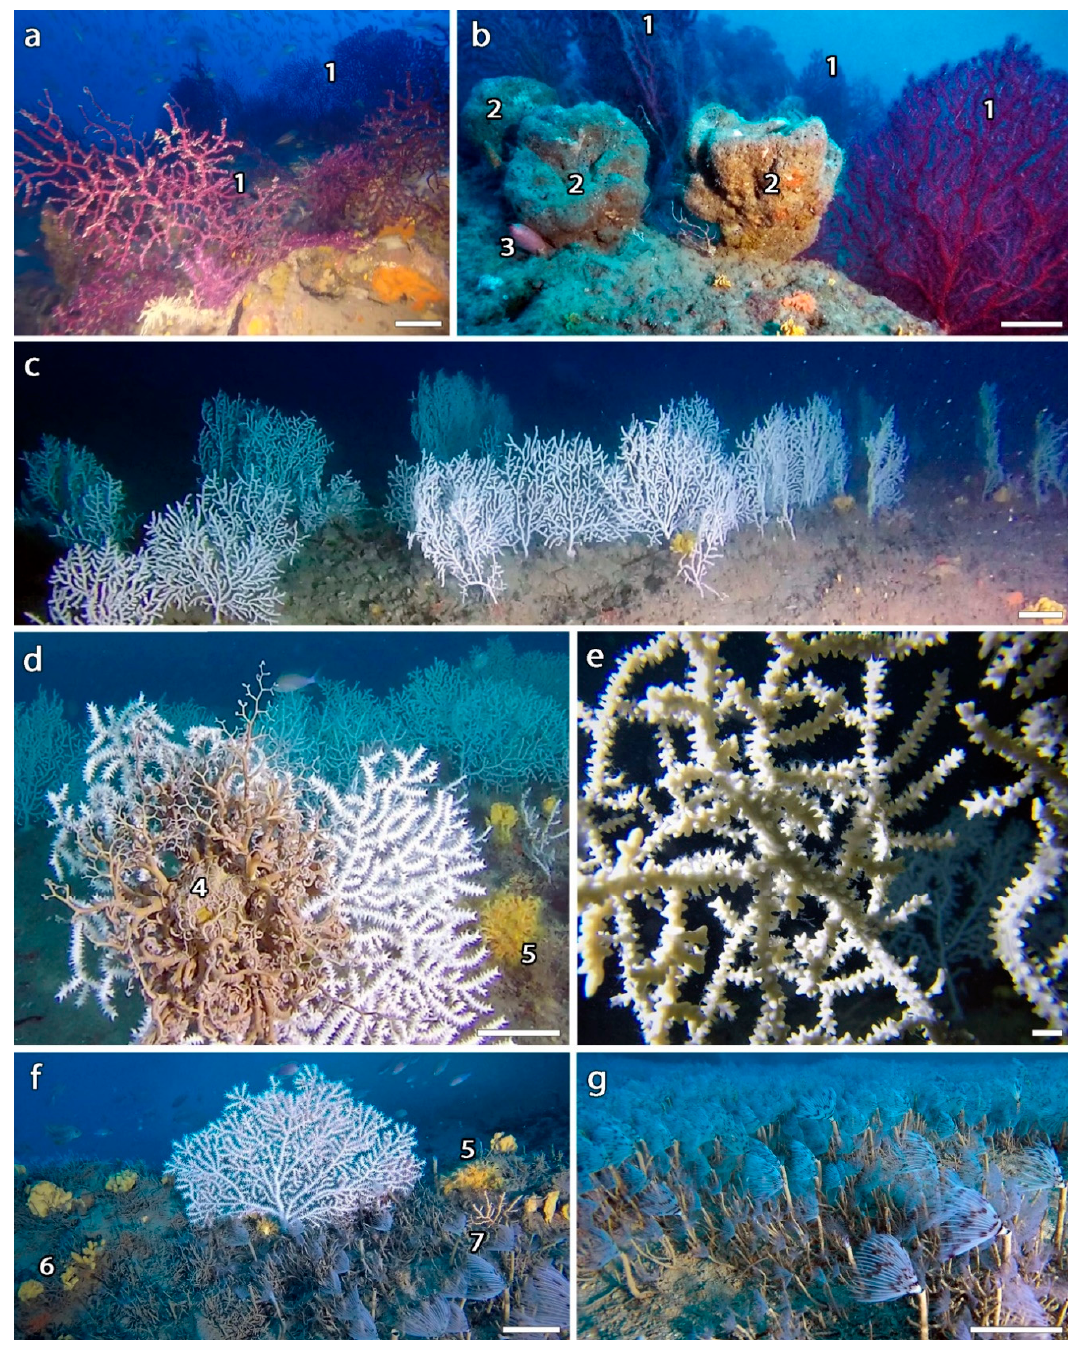
Figure 1. Benthic communities off Sanremo. ( a ) Forest of Paramuricea clavata (1), with ( b ) massive sponges (2) and the ascidian Halocynthia papillosa (3); ( c ) forest of Eunicella verrucosa , with ( d ) the epibiont ophiuroid Astrospartus mediterraneus (4), and the sponges Axinella sp. covered by Parazoanthus axinellae (5); ( e ) living polyps of E. verrucosa ; ( f ) isolated colony of E. verrucosa on the rocky bottom nearby the coral forest, whose community is locally dominated by Axinella spp. with (5) and without (6) P. axinellae , as well as the polychaete Sabella pavonina (7); ( g ) detail of S. pavonina population. Scale bars: a–d,f,g, 10 cm; e, 1 cm.